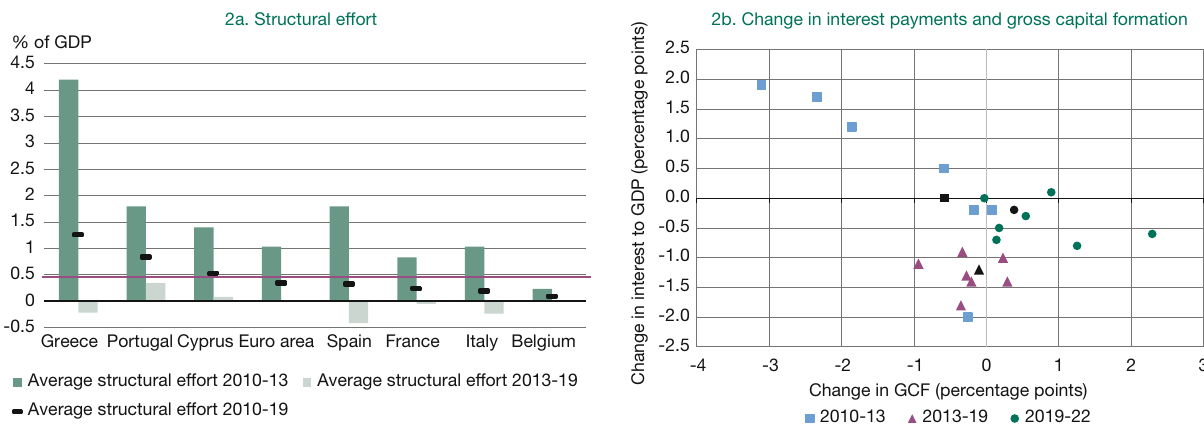
Notes: The fi gures show countries with public debt-to-GDP ratios above 90% in 2021. In Figure 2a, the horizontal line refers to the Stability and Growth Pact’s benchmark requirement of structural eff ort, i.e. 0.5% of potential output. In Figure 2b, the black points refer to the euro area aggregate, while the other points refer to the higher-debt countries, as identifi ed in Figure 2a (all points denote average values over the periods shown in the legend). GCF stands for public sector’s gross capital